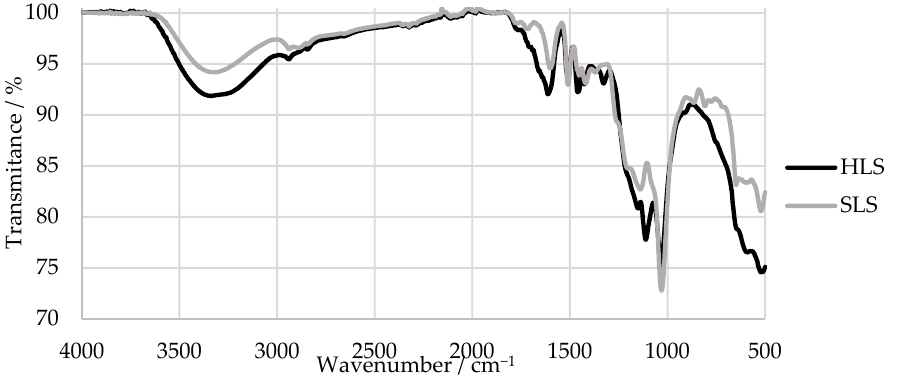
Figure 6. FTIR spectra of the HLS and SLS samples. Table 3. FTIR absorption band assignments of the SLS and HLS samples [34,49,52–54].